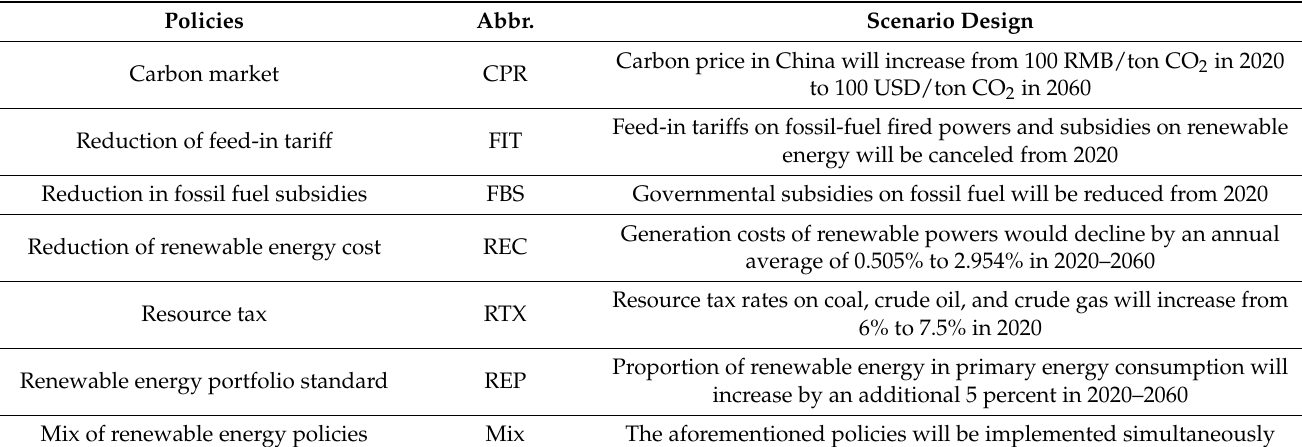
Table A1. The summary of renewable energy